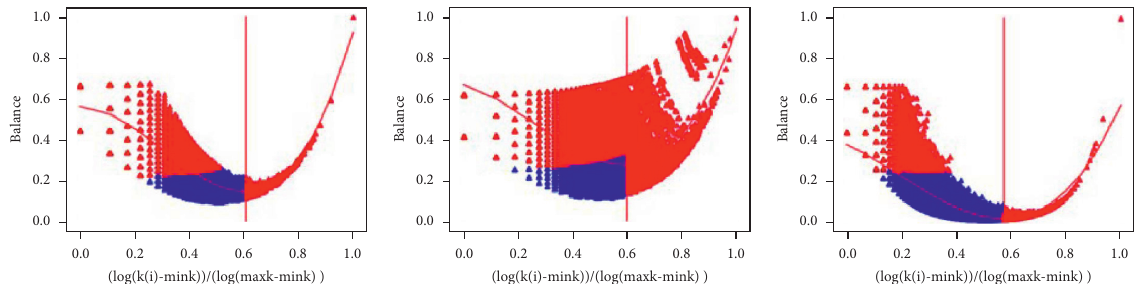
Figure 4: Red and blue partition